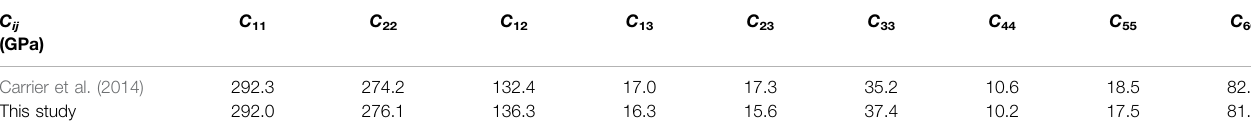
TABLE 1 | Comparison of calculated the elastic coef fi cients of the MMT at 1 Bar and 300 K by Carrier et al. (2014) and by the method provided in this